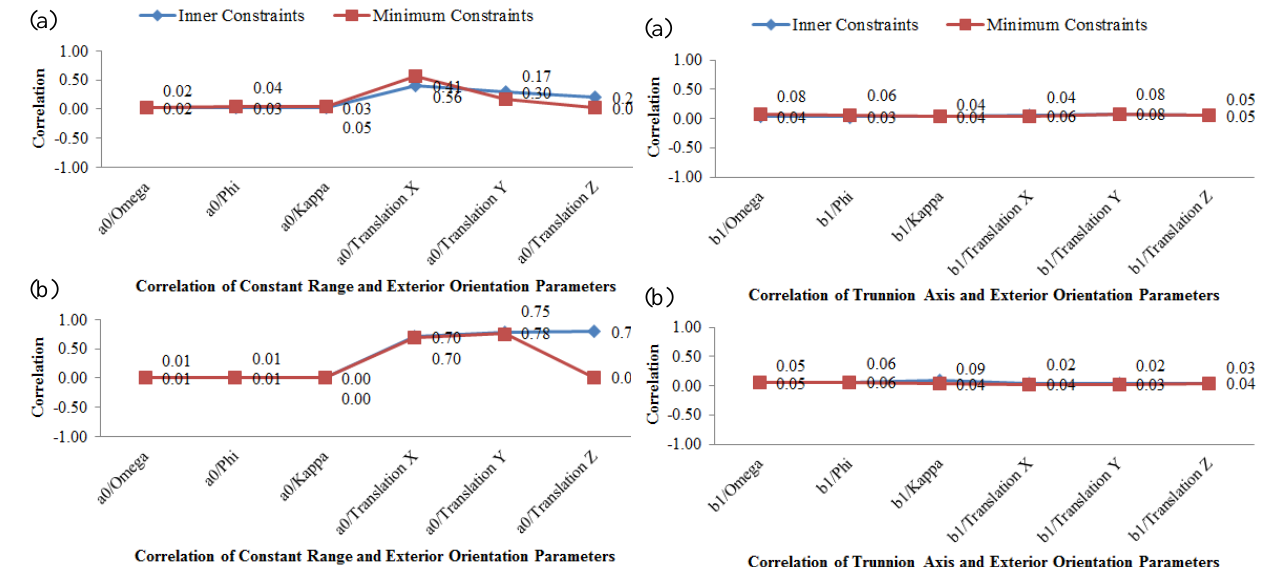
Figure 8. Parameter correlations of trunnion axis and exterior orientation parameters (full network configuration) ), (a) Faro Photon 120 and (b) Faro Focus 3D.